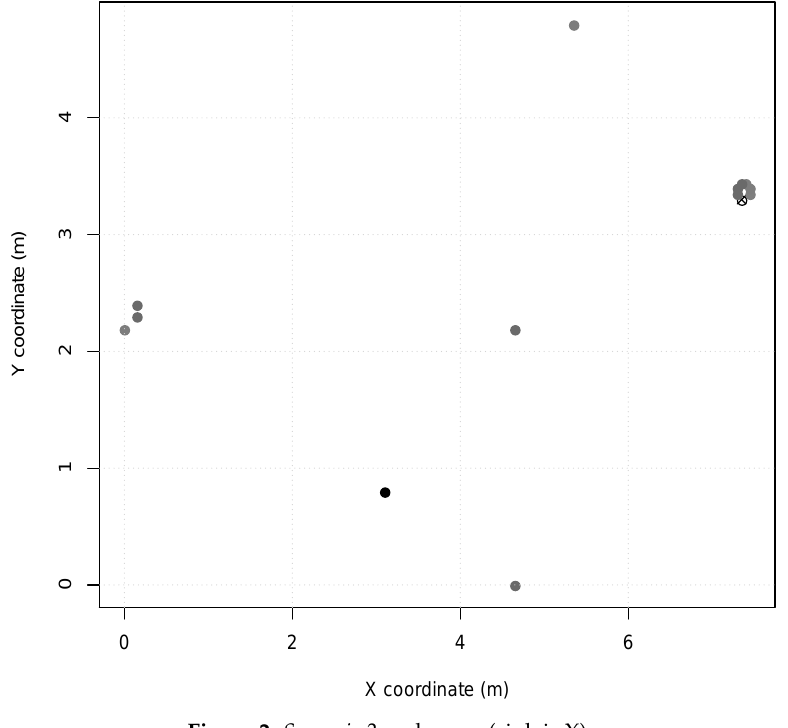
Figure 2. Scenario 2 node map (sink is X).